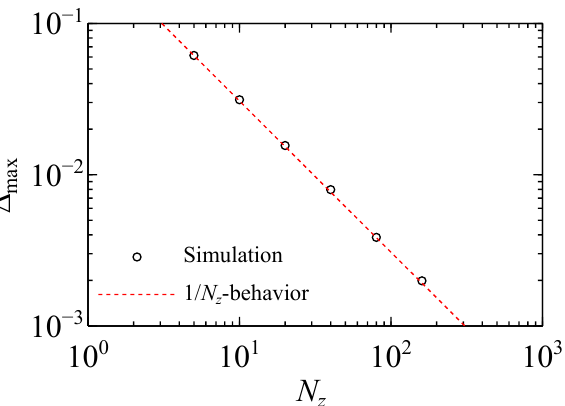
Figure 5. Mesh dependence of the maximum normal deviation, ∆ max . The number of mesh cells along the gap is 200, and the number of cells across the gap is denoted by N z . The number of iterations carried out is 200 at step length τ = 0.4.